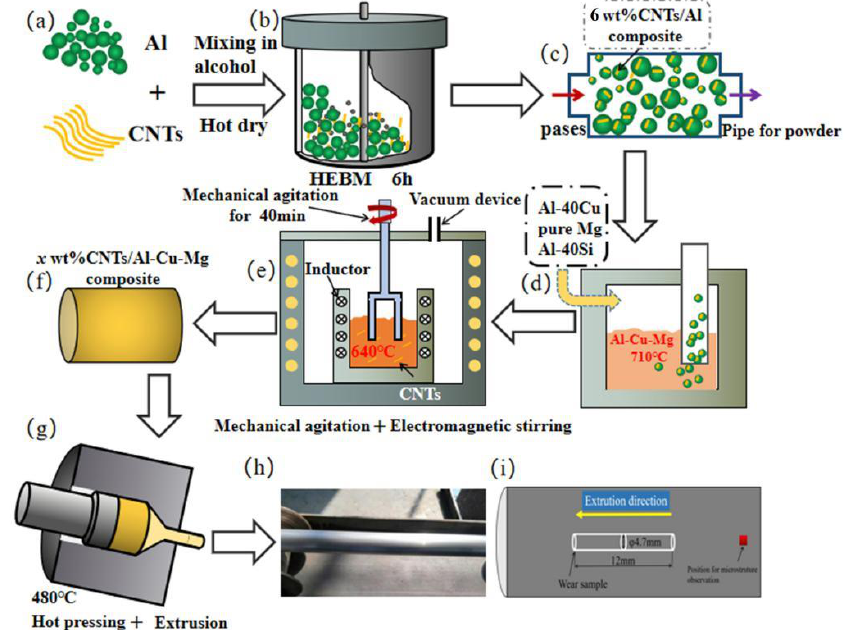
Figure 1. ( a – i ) Schematic diagram of preparation route for x % CNTs/Al-Cu-Mg-Si composites and semi-solid stir casting.